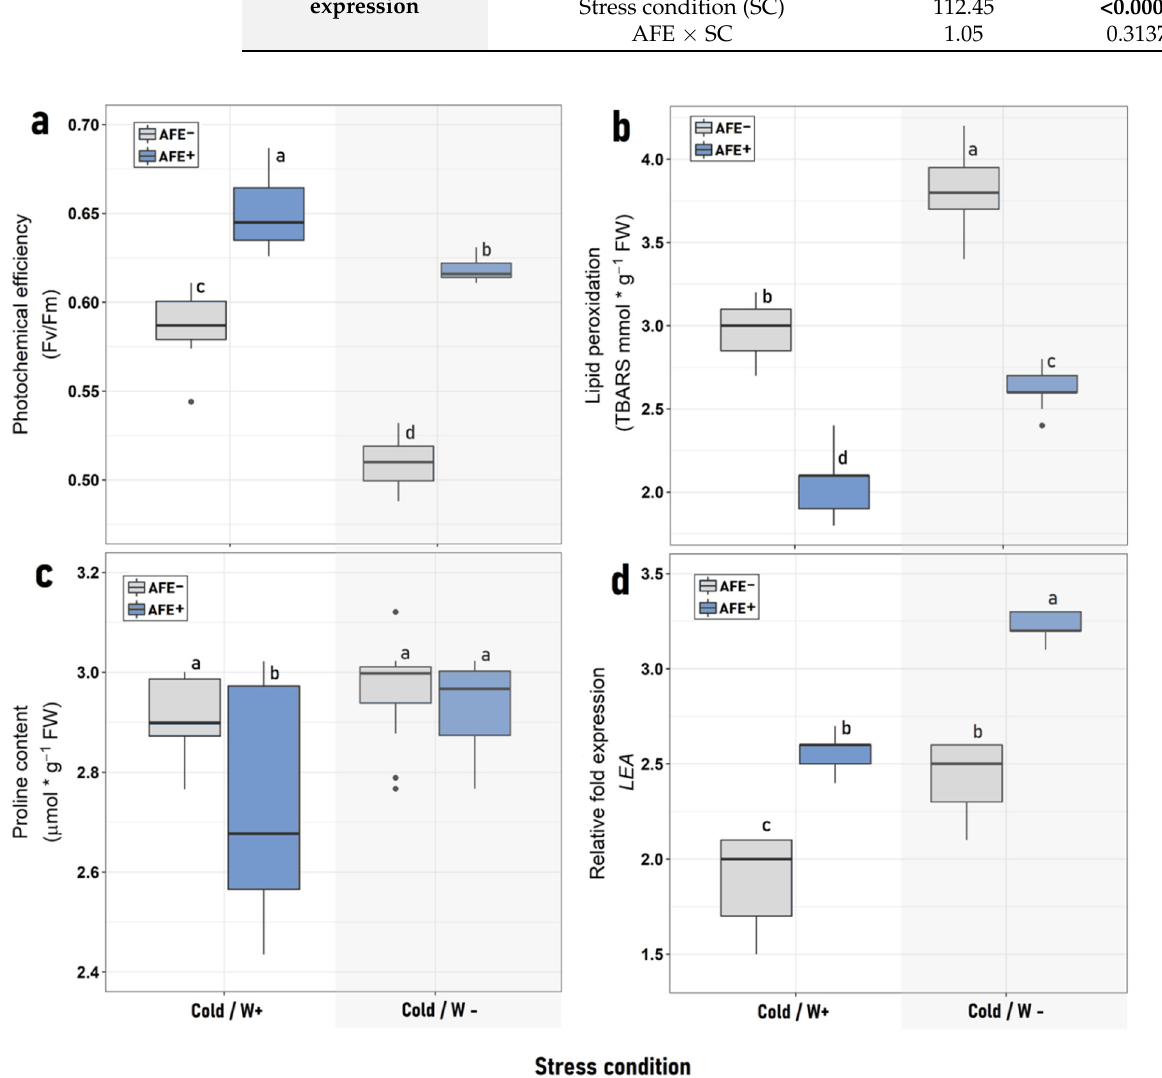
Figure 1. Box plots showing the effects of fungal endophyte inoculation (AFE+ or AFE − ) and stress condition (cold without water deficit (Cold/W+) or cold and water deficit (Cold/W − )) on the physiological ( a – c ) and molecular ( d ) response varia- bles of blueberry plants ( Vaccinum corymbosum , cv Briggita). Different letters represent significant a posteriori differences (marginal mean pairwise comparisons, p < 0.05) assessed on the respective linear mixed-model (LMM) group estimations. The mid black line represents the data group median, while the box and bars represent the interquartile data distribution. Dark gray dots represent data